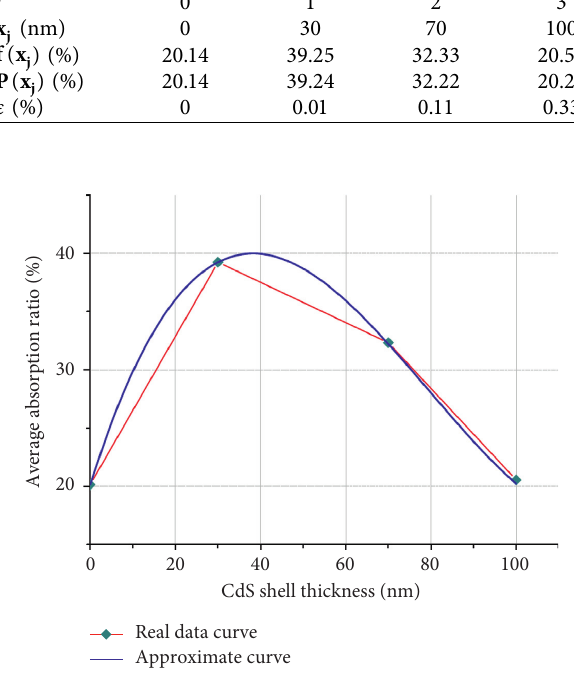
Figure 7: The average absorption rate of increase as a function of CdS shell thickness.